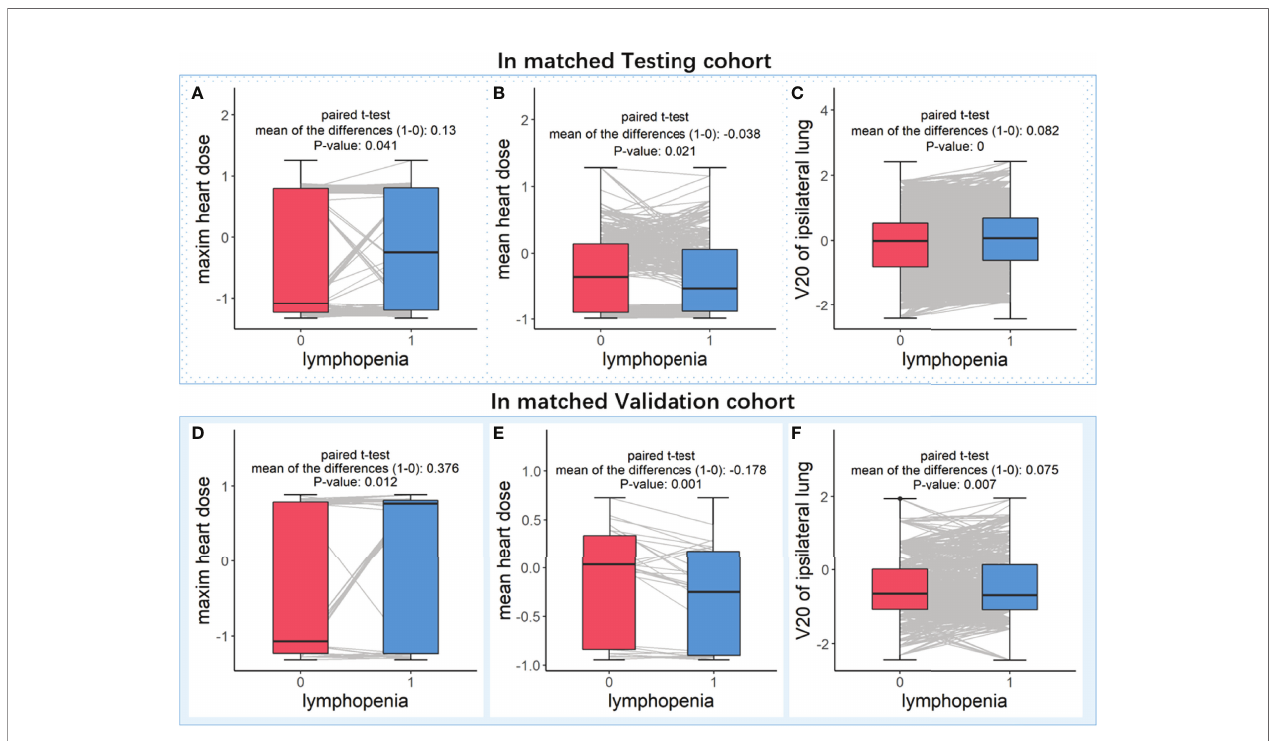
FIGURE 5 | Paired t-test analysis in matched patients who with controlled discrepancy of important features. Subplots (A – C) are analyzed in the matched patients in Testing cohort, and subplots (D – F) are analyzed in the matched patients in Validation cohort. In the paired patients of each cohort, three boxplots (from left to right) were the comparisons of feature levels between with (blue box) and without (red box) lymphopenia in ( A or D ) maxim heart dose, ( B or E ) mean heart dose and ( C or F ) V20 of ipsilateral lung,